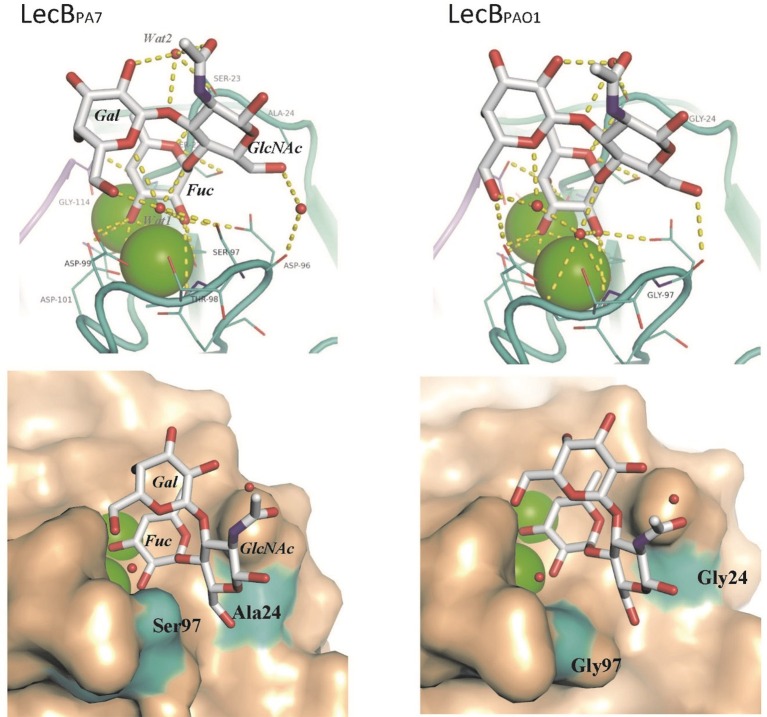
Comparison of the crystal structures of LecBPA7 (this work) and LecBPAO1 (PDB code 1W8H) complexed with Lewisa. Calcium ions are depicted as green spheres and water molecules as red spheres. Top Panel: detail of the binding sites with hydrogen bonds as dotted yellow lines. Bottom Panel: surface representation of the binding site. Two amino acids with a modified positioning have been colored in cyan.